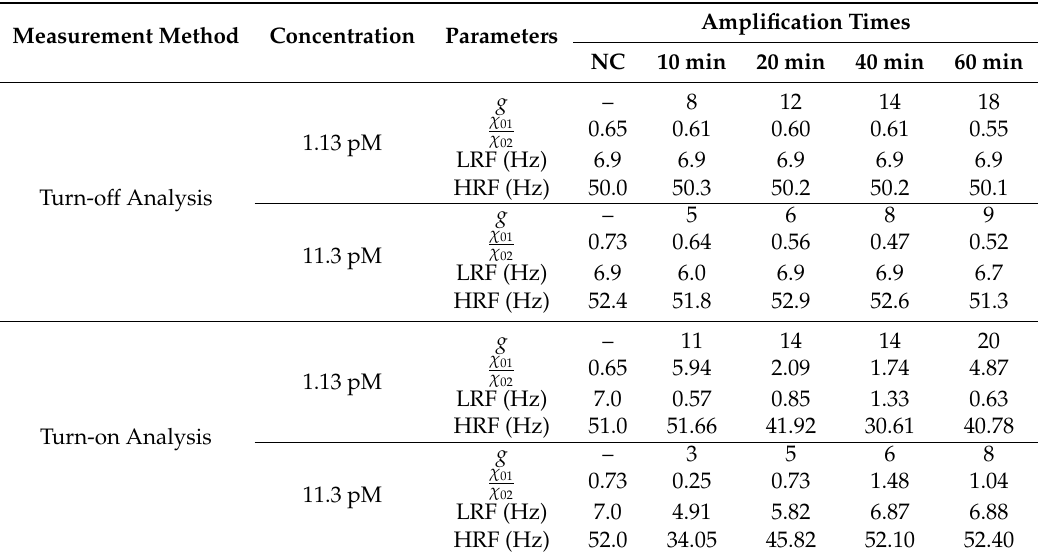
Table 1. Estimated number of MNP markers per RCPs, g , for each amplification time and RCP concentration calculated using Equation (1) and the bi-modal Cole-Cole fitting parameters for the turn-off and turn-on (DHMA) analysis presented in Figures 1 and